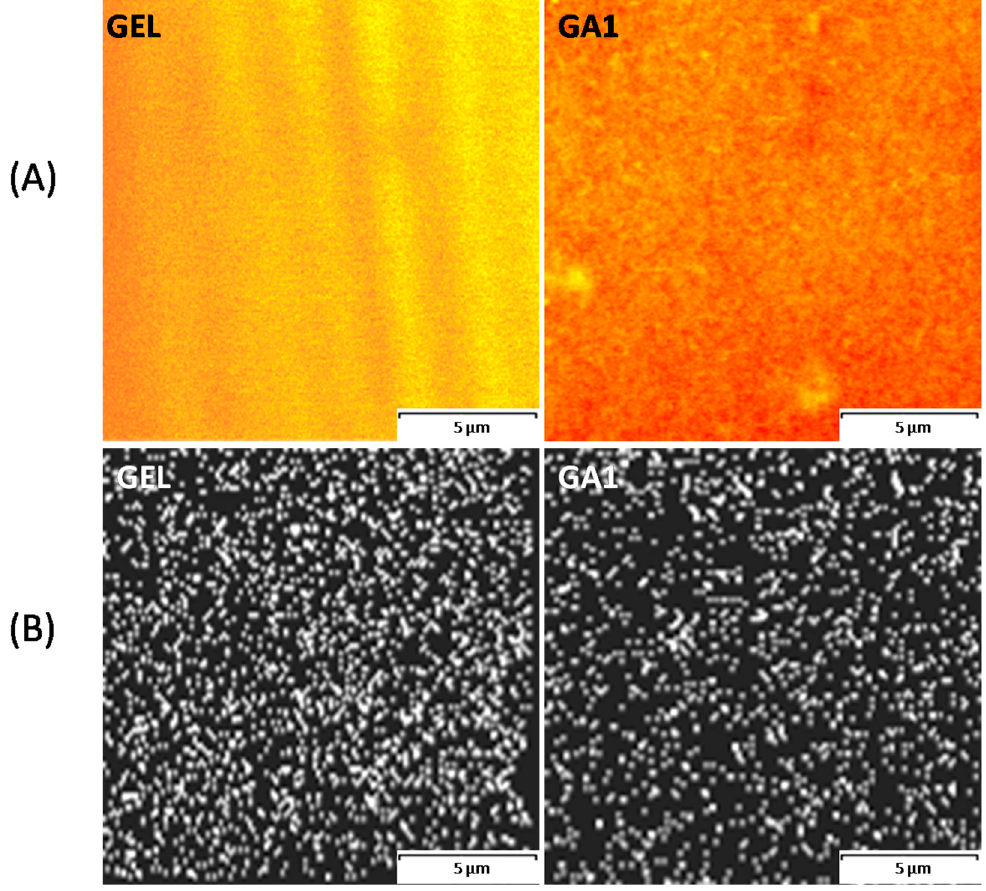
Figure 1. Comparison of the acridine orange distribution ( A ) and nitrogen distribution ( B ) in GEL and GA1 films. Scale bar—5 μ m. The stripes on the GEL image ( A ) are the result of the slightly uneven thickness of the investigated film.